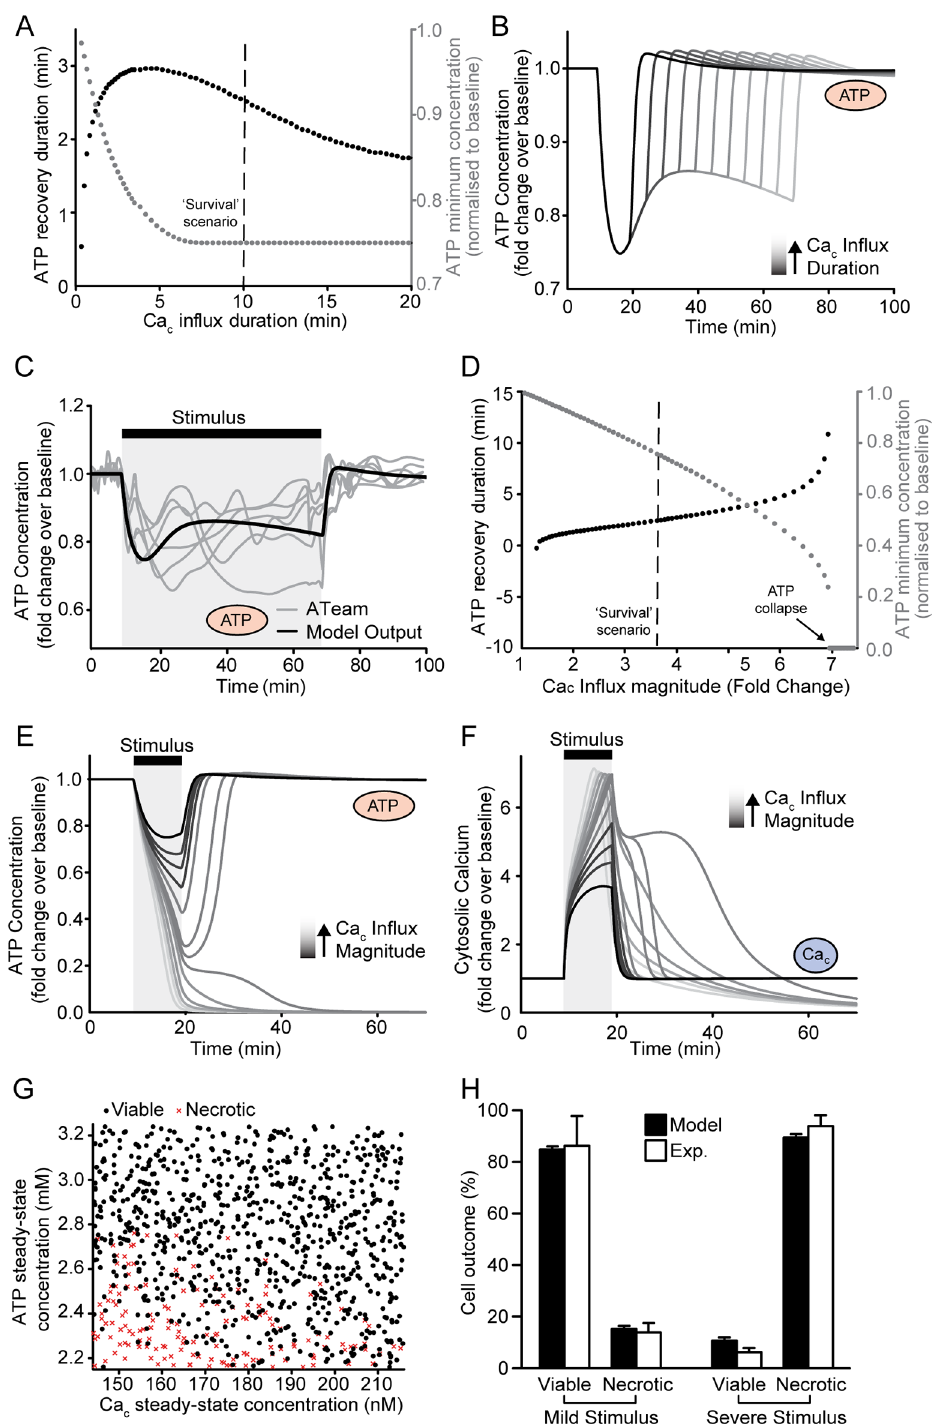
Fig 4. The computational model can represent the bioenergetic collapse induced by severe excitotoxicity, modelling neuronal necrosis. We investigated the predicted responses following more severe excitotoxic stimuli by increasing the (A-C) duration or (D-F) magnitude of the applied calcium influx (model input). (A) Prolonging the Ca c influx beyond 5 min did not predict further depletion of ATP beyond a minimal level (grey dots). In contrast, longer periods of Ca c influx were predicted to speed up ATP recovery (black dots). The calcium influx for which the graphs in Fig 1 were plotted is indicated with a black dashed